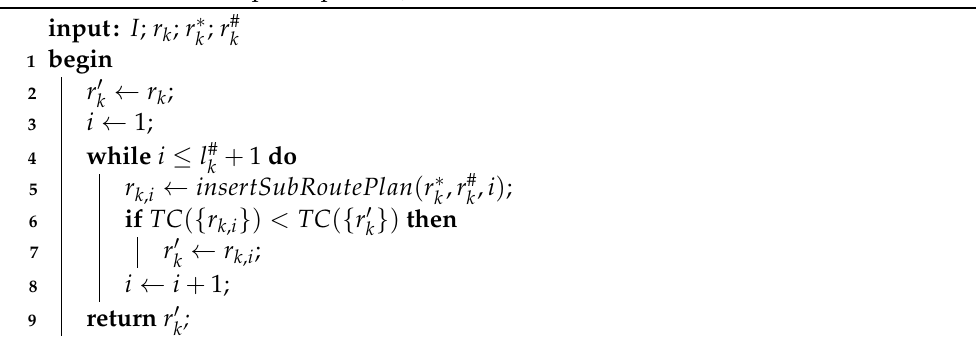
Algorithm 7: greedyReconnection (algorithm of the greedy reconnection method within the sub-route plan